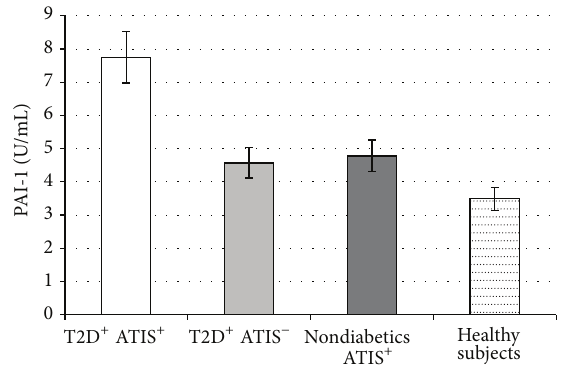
Figure3:Valuesaremeans ± SE.BargraphsshowthevaluesofPAI-1 levels. PAI-1 levels were significantly higher in type 2 diabetes (T2D) patients with atherothrombotic ischemic stroke (ATIS) compared to T2D patients without ATIS ( 𝑃 < 0.001 ) and in nondiabetics with ATIS compared to healthy subjects ( 𝑃 < 0.001 ). PAI-1 levels were not different among T2D patients without ATIS and nondiabetics with ATIS ( 𝑃 = NS) (analysis of variance (ANOVA) with post hoc Tamhane